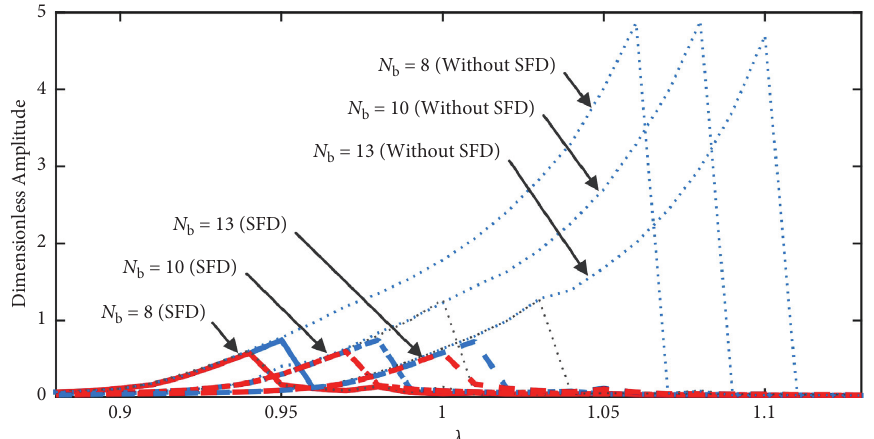
Figure 8: The amplitude-frequency curves in subharmonic VC frequency resonance region, where ° indicates run-up and × indicates run-